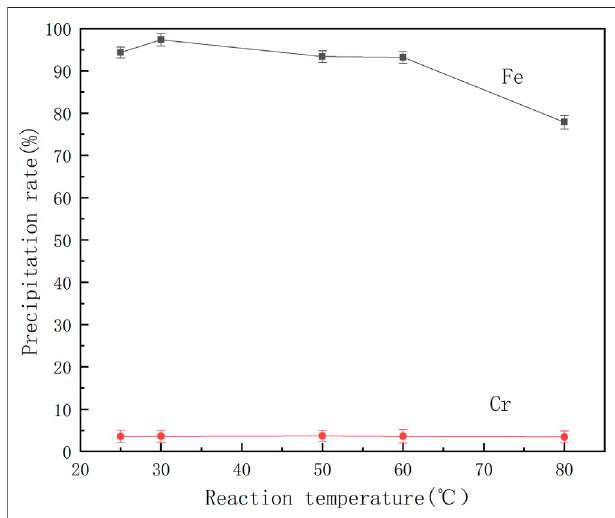
FIGURE 5 | Effect of reaction temperature on precipitation rate of ferrochrome.